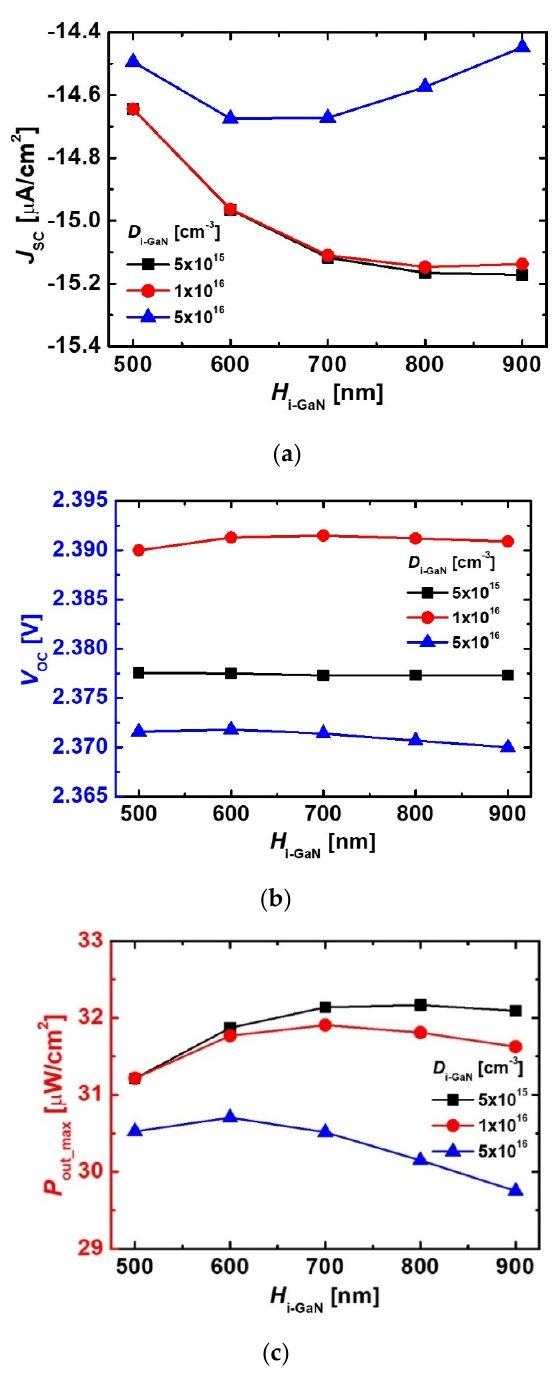
Figure 6. Variations of ( a ) J SC , ( b ) V OC and ( c ) P out_max of the e-beam-irradiated diodes depending on